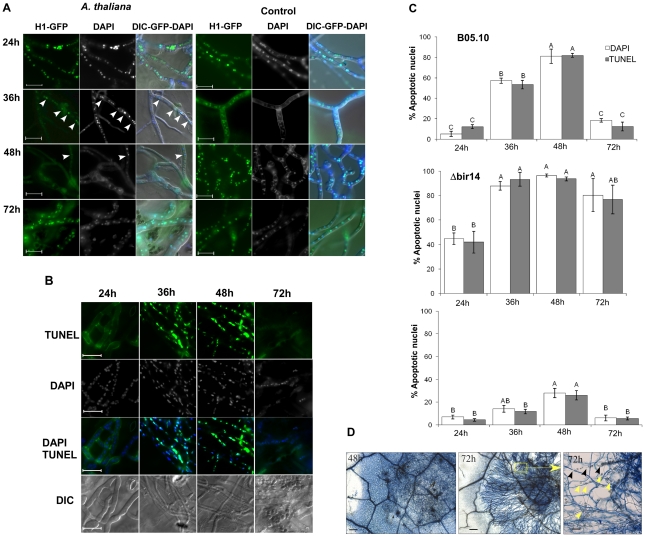
Disease symptoms are negatively correlated with PCD in Botrytis.(A) Plants were inoculated with the B. cinerea H1-GFP. Images show gradual decrease in the number of fluorescent nuclei between 24–48 h, and then recovery of the signal at 72 h. Very few nuclei are visible at 48 h (arrowhead). Control panels (right) show hyphae that were developed following spore germination on PDA medium. Abundant nuclei signal are observed at all times. (B) TUNEL and DAPI staining of B. cinerea on infected leave of A. thaliana. Leaves of Col-0 plants were inoculated with B. cinerea B05.10 wild type strain and TUNEL assay was performed to determine PCD in the developing hyphae. The green fluoresce of nuclei in these images indicate positive TUNEL staining of nuclei, i.e., apoptotic cells. Bar  =  20 µm. (C) Levels of PCD during infection of A. thaliana Col-0 wild type plants with the B. cinerea BcBIR1 mutant strains. Col-0 plants were inoculated with B05.10 wild type, Δbir14 mutant and BIR24 over expression strains. PCD was recorded by DNA strand break (TUNEL assay) and chromatin condensation (DAPI staining). Data represent mean ±SEM for triplicate samples of 200 nuclei per sample (n = 3). The effect of fungal genotype and infection phase on PCD level was determined using two-way ANOVA. Columns not connected with the same letter are statistically different (p<0.05) as determined by two-way ANOVA (p<0.001) followed by a post-hoc Tukey HSD analysis. (D) Typan blue staining of Botrytis-infected Arabidopsis leaves. Leaves of A. thaliana Col-0 plants were inoculated with a spore suspension of B. cinerea B05.10. Leaves were stained with trypan blue 48 h and 72 h PI. Blue staining of plant cells surrounding the fungal mycelium indicates dead plant cells. The right panel shows a higher magnification of the inset from the middle panel (both from 72 h PI). Degradation of the leaf veins (black arrowheads) and accumulation of vesicles that are produced from remnants of plant cells (yellow arrowheads) show complete maceration of the tissue in the center of the lesion. Bars in first two panels (48 h and 72 h)  =  100 µm, bar in last panel (inset 72 h)  =  20 µm.